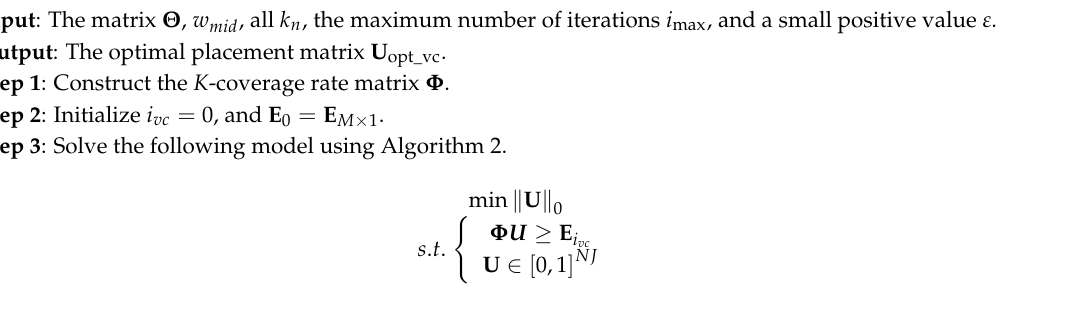
Algorithm 3: The iterative varying constraint algorithm for solving (15)